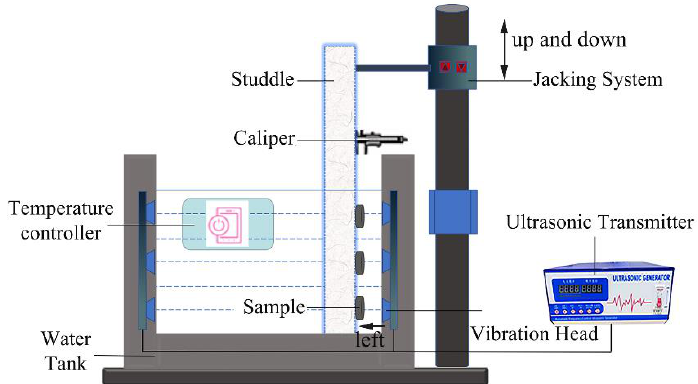
Figure 2. Schematic of the ultrasonic cavitation erosion device.